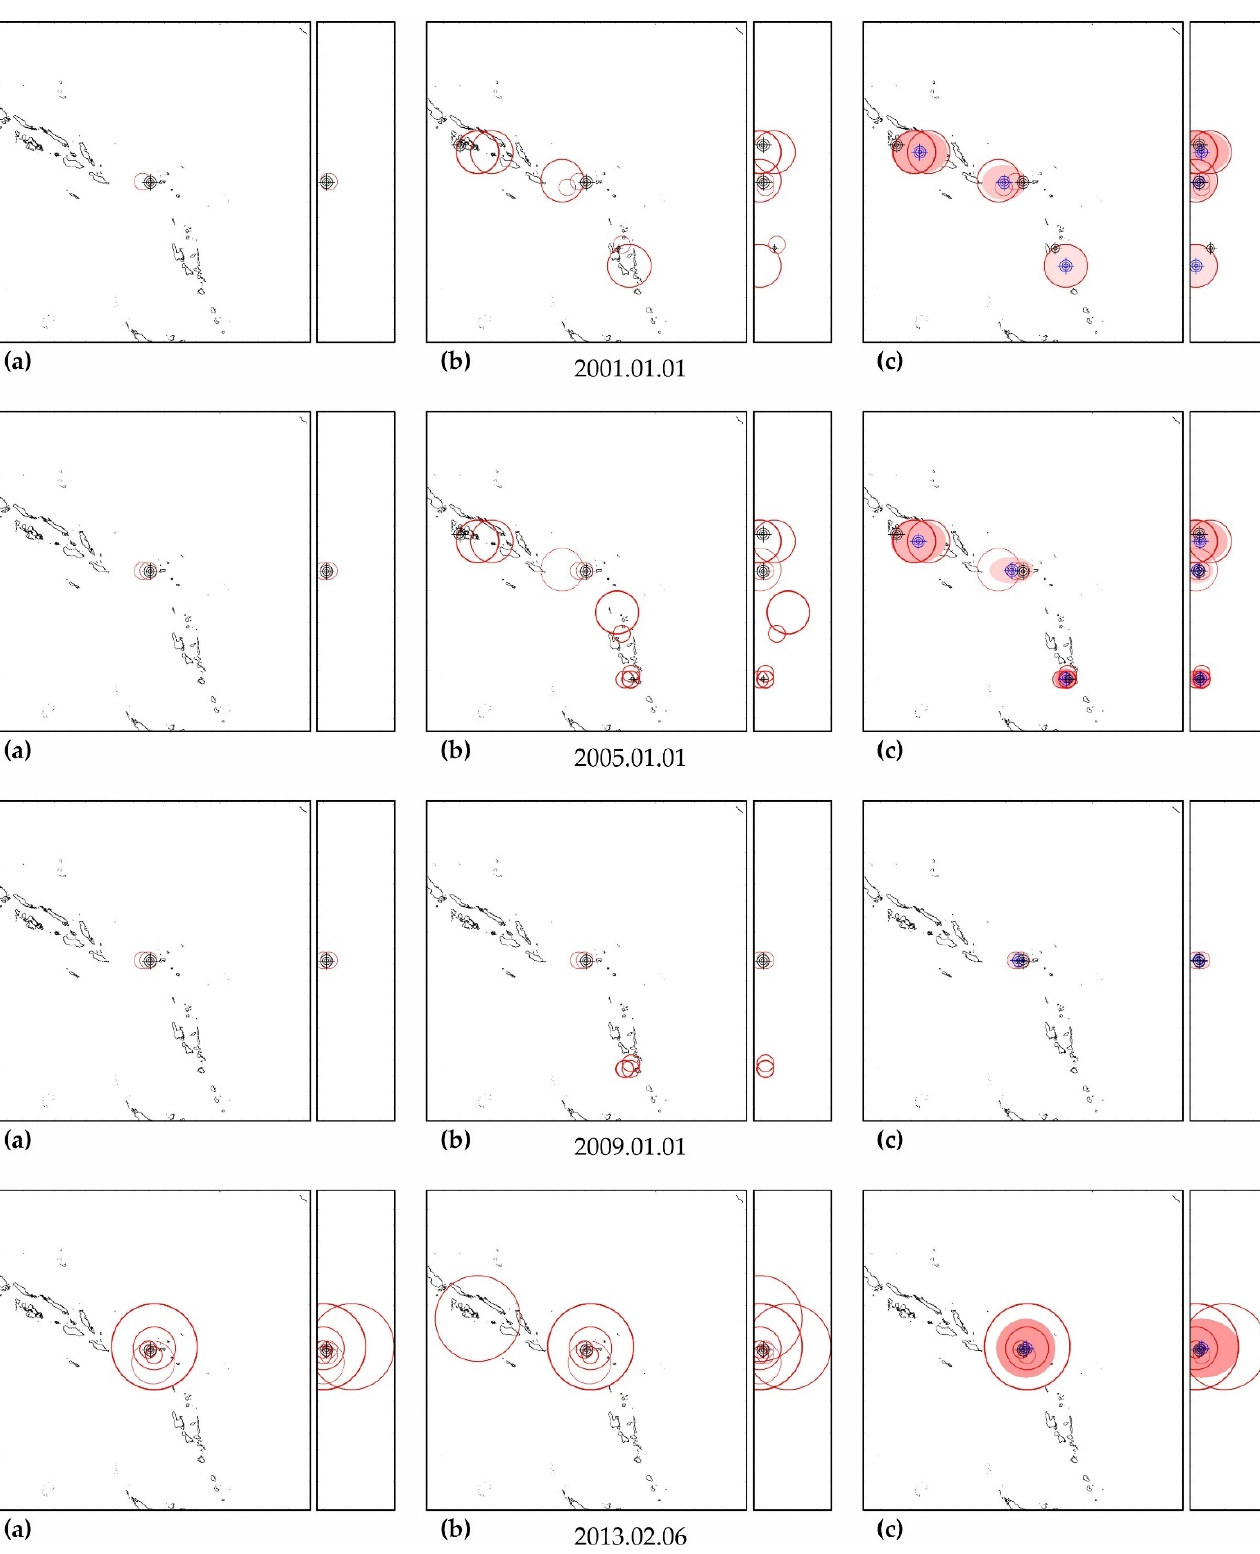
Figure A11. Zones of factual predictability for the earthquake of 6 February 2013 ( a ), identified zones with similar development according to the parameters of the DSDNP equation ( b ) and a cluster of zones of the greatest activity ( c ) used to calculate the time and place of a precedent earthquake (see Figure A3 for explanations). Clusters of predictability of other earthquakes (9 January 2001 M7.1, 1 April 2007 M8.1 and 10 August 2010 M7.3) were also found with similar preparations.